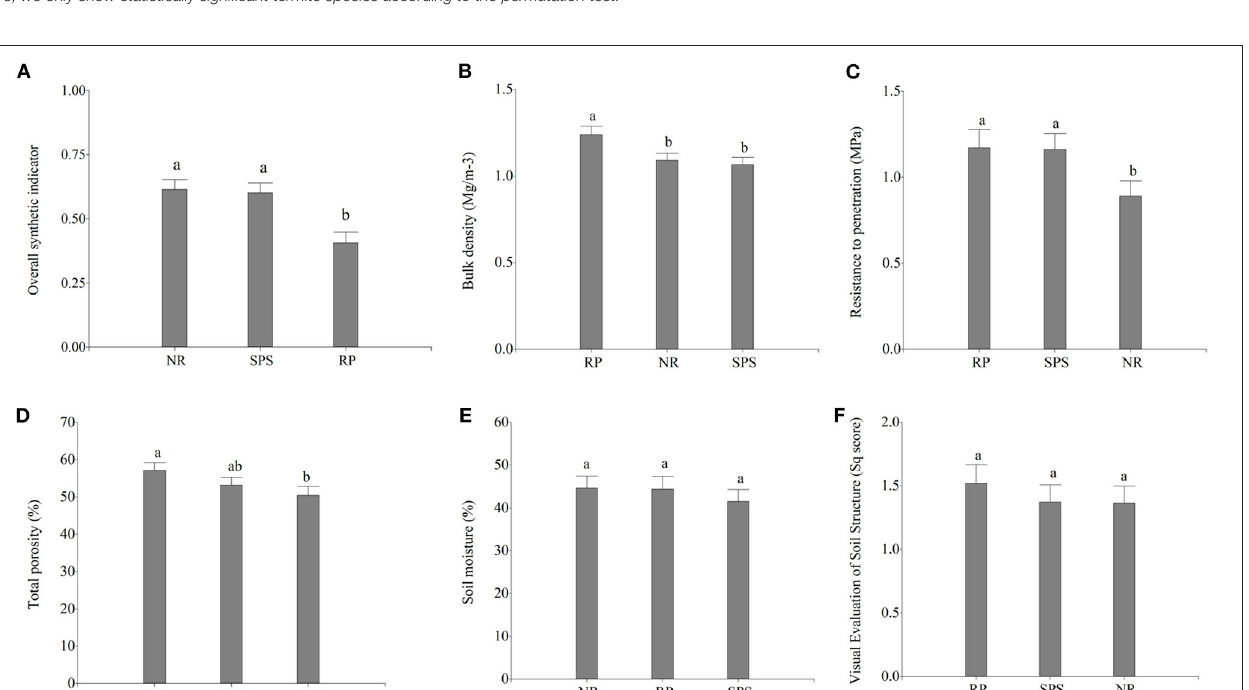
TABLE 5 | Similarity-percentage analysis (SIMPER) comparing species composition of termites collected in natural regeneration (RN), silvopastoral systems (SPS), and rubber plantations (RP) in Colombian Amazon region. Land use Specie Cumulative Natural regeneration vs. Rubber plantation